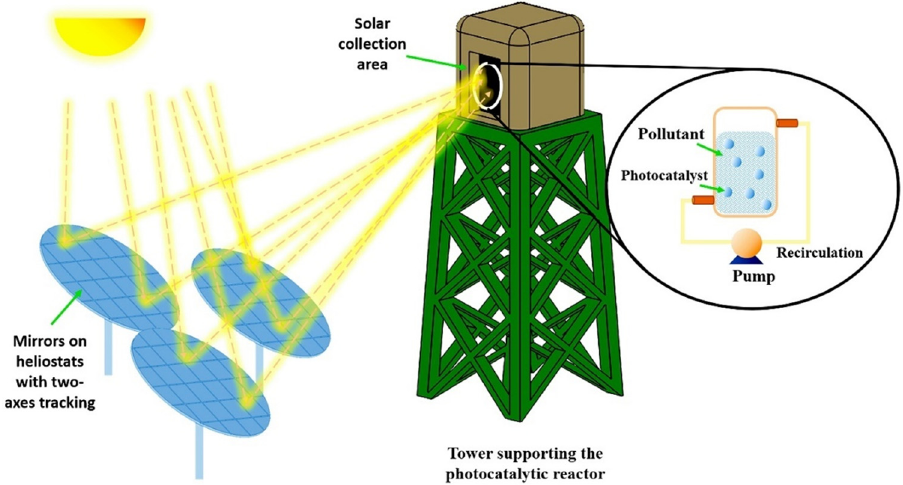
Figure 7: Diagram of the recirculation reactor and the outer test